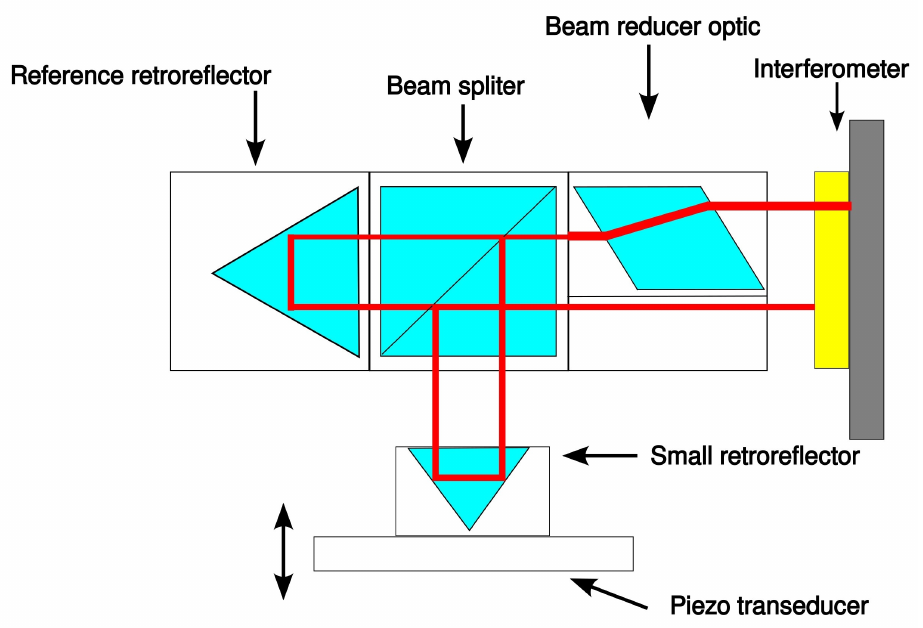
Figure 2. Schematic view of the optical path for the measurements with the XL-80 interferometer system